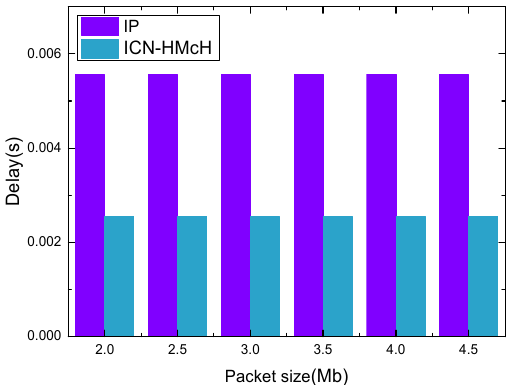
Figure 15. Throughput variation for two structured packets.